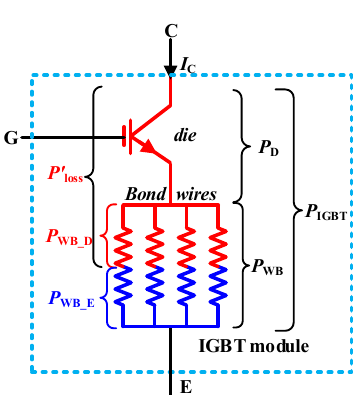
Figure 4. Power loss of IGBT module.